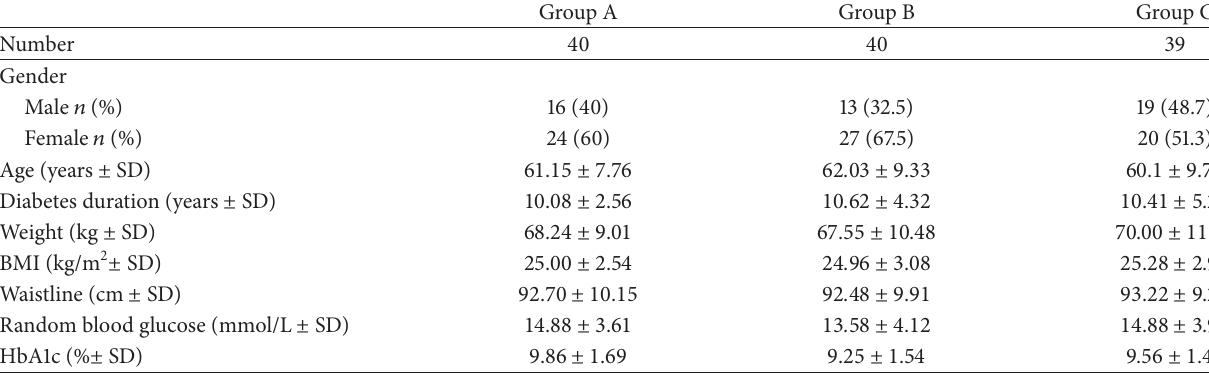
Table 1: Patient demographic characteristics.